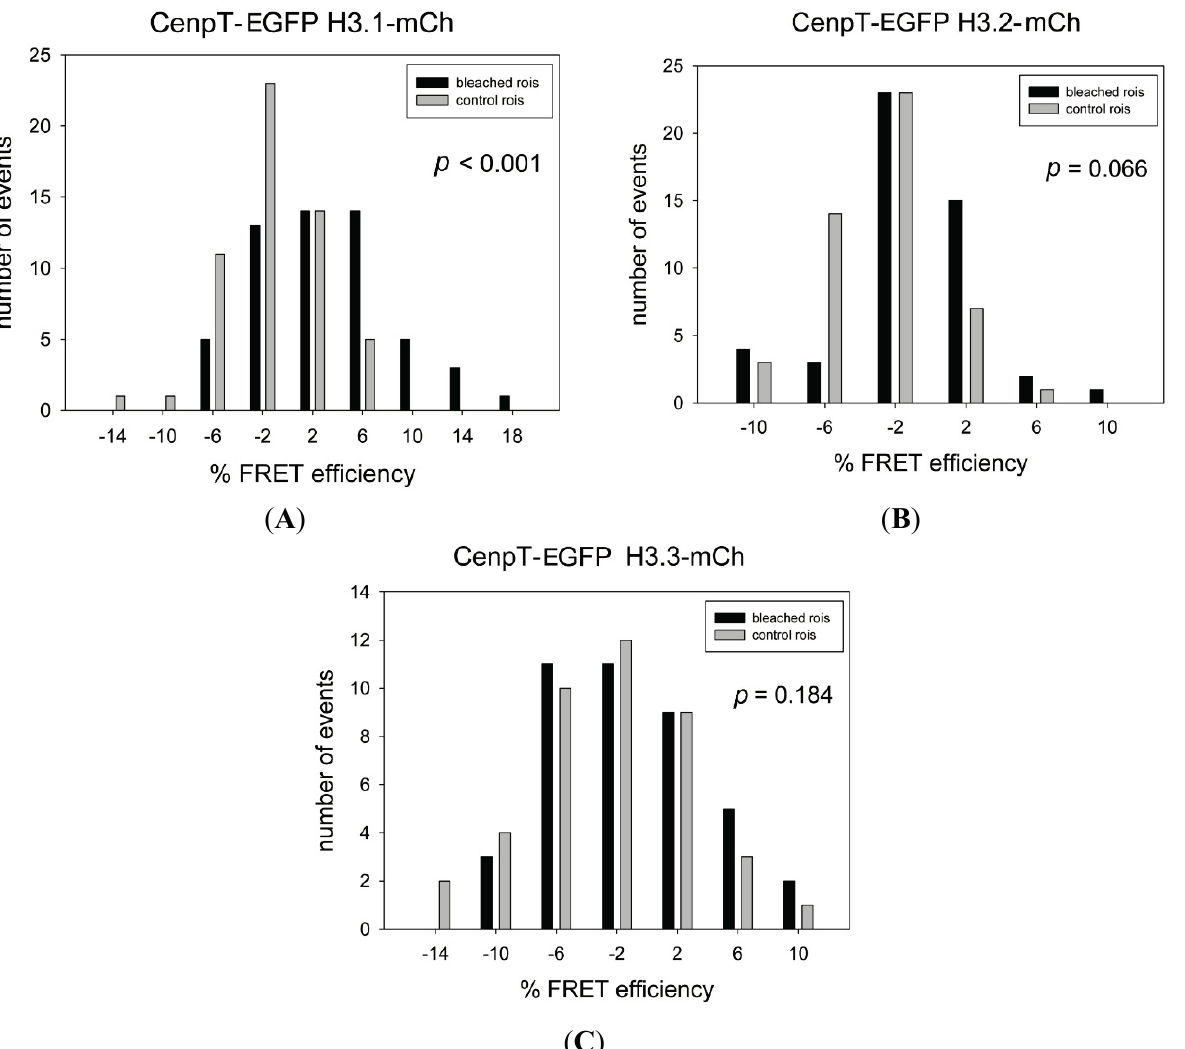
Figure 2. Acceptor-bleaching Förster Resonance Energy Transfer (FRET) between CENP-T-EGFP and ( A ) H3.1-mCherry; ( B ) H3.2-mCherry and ( C ) H3.3-mCherry. In one spot in the cell containing kinetochores, the acceptor mCherry is bleached and the donor EGFP fluorescence is measured before and after the bleach. From the difference, the FRET efficiency E FRET is calculated and grouped according to 4% deviation categories (black